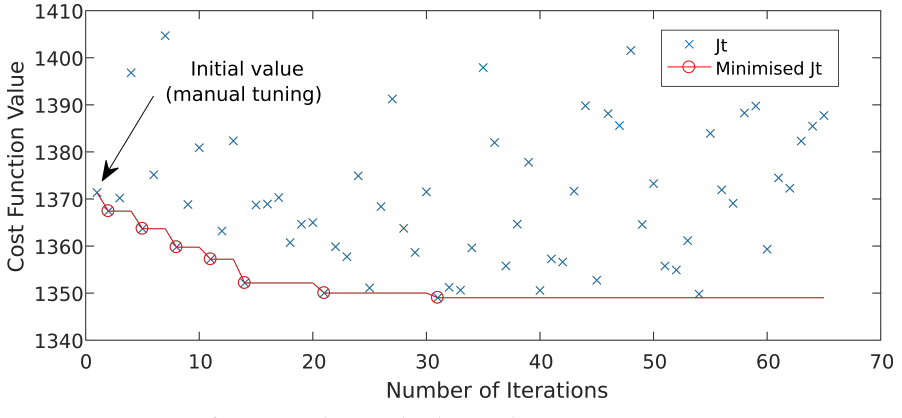
Figure 6. Cost function value results during the iterative optimisation process. Table 1. Manually tuned and optimised control parameters values after applying the PZO